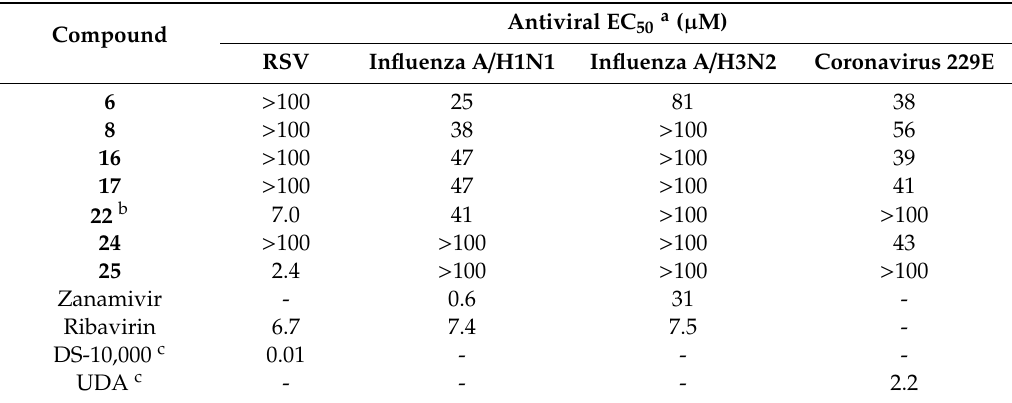
Activities of compounds 6 , 8 , 16 , 17 , 22 , 24 and 25 against three di ff erent human respiratory